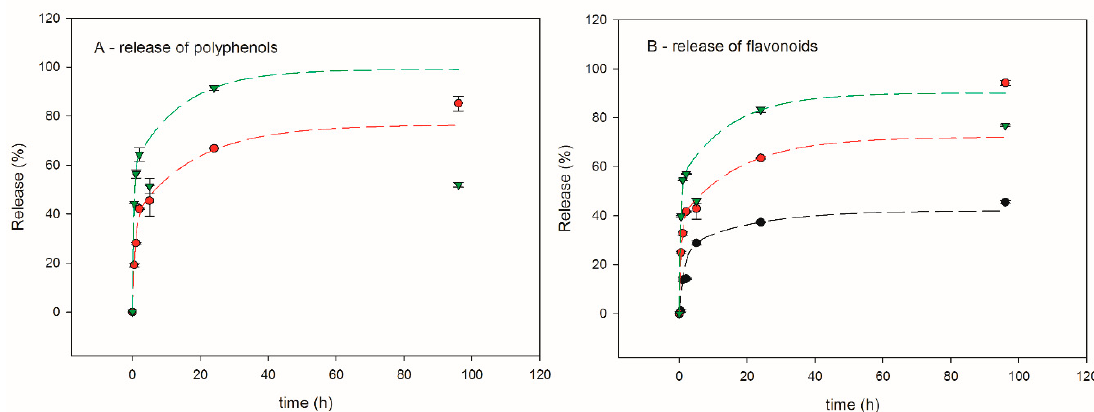
Figure 8. Propolis release kinetics in the mixture EtOH-H 2 O (7:3 v / v ). ( A ) release of polyphenols and ( B ) release of flavonoids. Experimental results: black dots (EP5); red dots (EP10); green dots (EP15). The corresponding exponential fitting are shown by dashed lines.